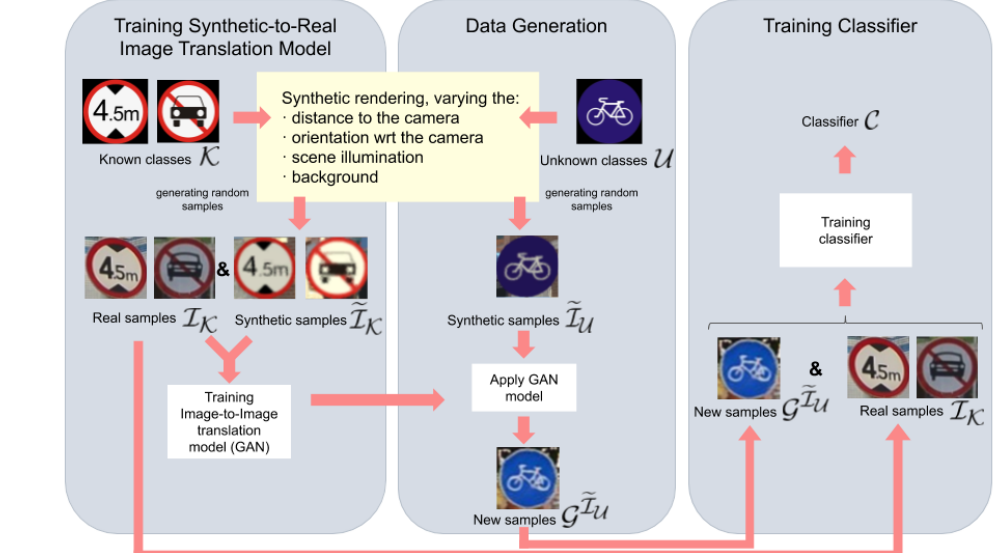
Figure 2. The proposed method for retraining a classifier, C , to keep detecting previously known classes ( K )—for which we have labeled real-world samples—and, in addition, new previously unknown classes ( U ) for which we do not have real-world samples. The key idea is to have synthetic samples for both the known and new classes. The real-world samples of the known classes ( I K ) and the synthetic ones ( (cid:101) I K ) are used to train a Generative Adversarial Network (GAN) with the aim of performing synthetic-to-real domain adaptation. In particular, the synthetic samples of the new classes ( (cid:101) I U ) are transformed ( G (cid:101) I U ) by this GAN. Then, the real-world samples of the previously known classes and the transformed synthetic samples of the new classes are used to train the desired classifier. The overall idea is illustrated for traffic sign